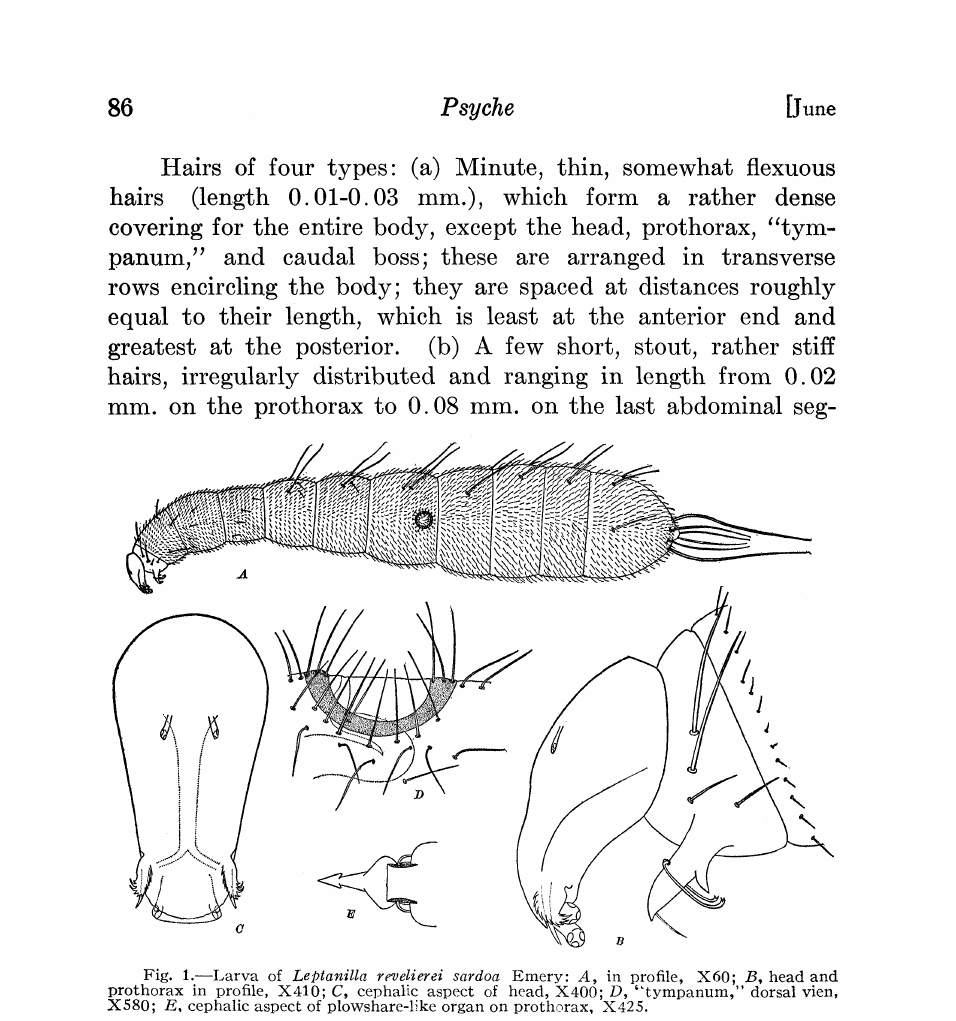
Fig. 1.--Larva of Leptanilla revelierei sardoa Emery: A, in profile, X60; B, head and prothorax in profile, X410; C, cephalic aspect of head, X400; D, "tympanum," dorsal vien, X580; E, cephalic aspect of plowshare-like organ on prothorax, X425.